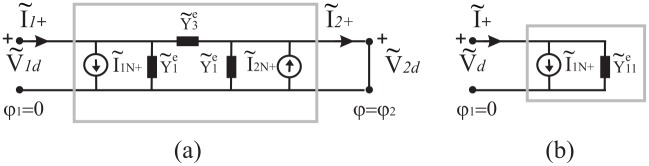
Network models of the problem describe in Fig 12.